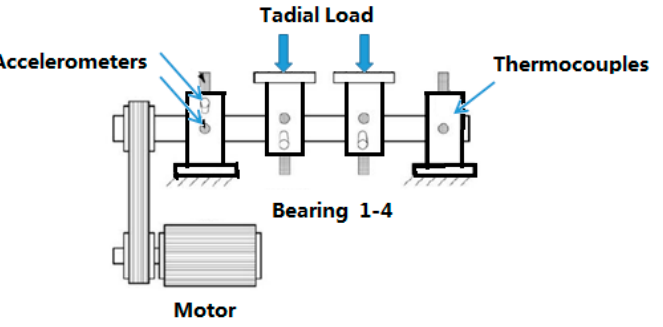
Figure 4. Illustration of the bearing test rig and sensor placement [23].